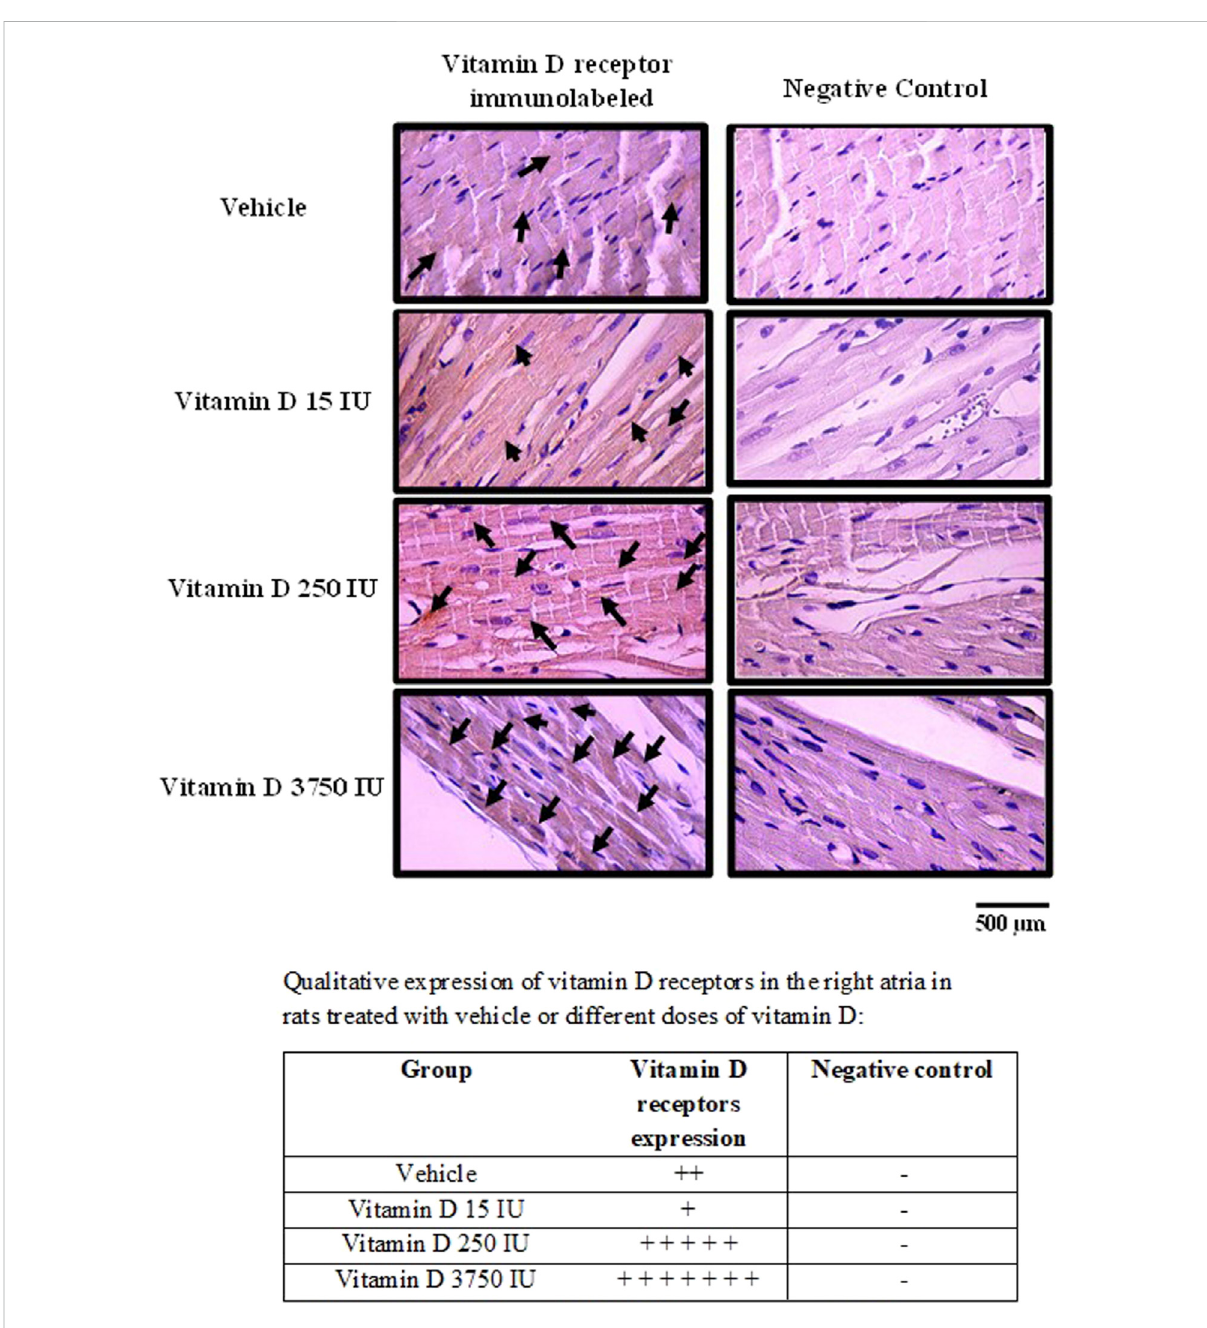
FIGURE 5 PhotomicrographofrightatriaslicesshowingvitaminDreceptors-immunolabeledinthecells(leftpanel)incontrolrats(treatedwithvehicle)or supplemented with different doses do vitamin D (15, 250 or 3,750 IU) for 3 days. Arrows show the immunostaining of vitamin D receptors. Negative controls (right panels) show absence of labeling for vitamin D receptors. Ampli fi cation: